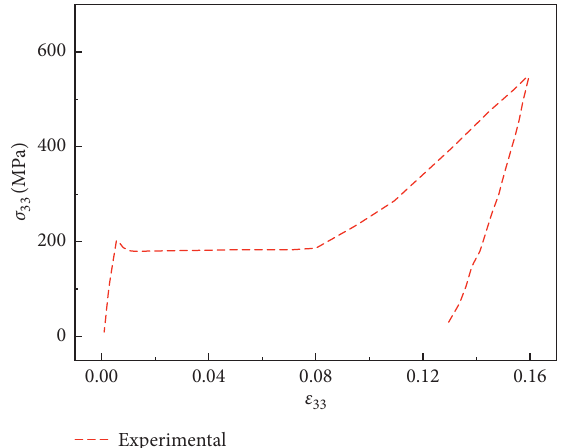
Figure 3: Experimental σ − ε tensile curve of NiTiNb SMA sample at − 60 °